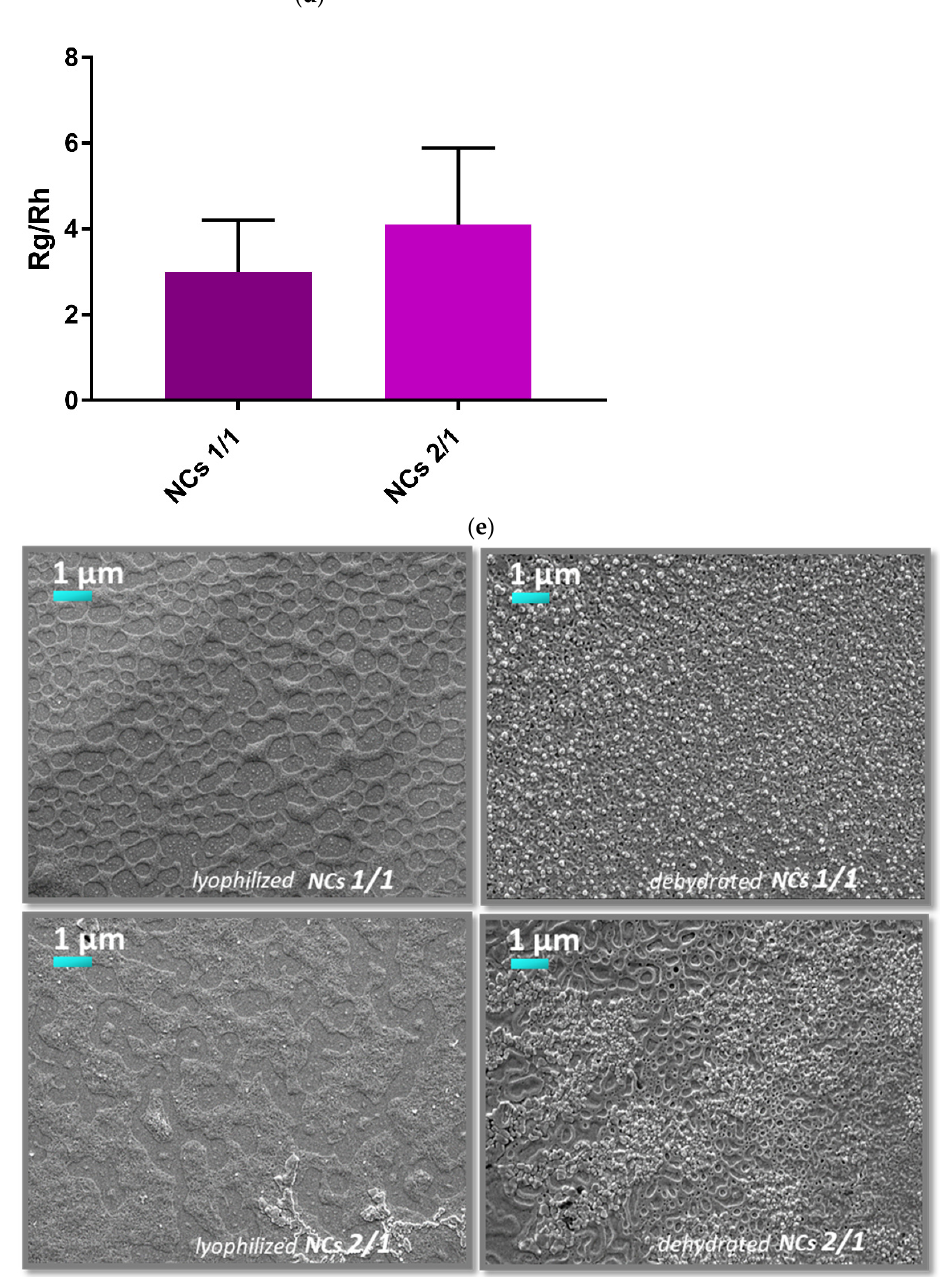
Figure 5. AF4-UV, graph overlap of cGAMP, linP25 and 1/1 linP25/cGAMP NCs. ( a ) AF4-UV, graph overlap of cGAMP, linP25 and 1/1 linP25/cGAMP NCs, ( b ) AF4-UV, graph overlap of cGAMP, linP25 and 2/1 linP25/cGAMP NCs ( c ) UPLC-UV, encapsulation efficiency vs. AF4-UV recovery of 1/1 and 2/1 NCs, ( d ) AF4-DLS, shape factor Rg/Rh and ( e ) SEM: dehydrated and lyophilized samples of 1/1 and 2/1 NCs. n = 3